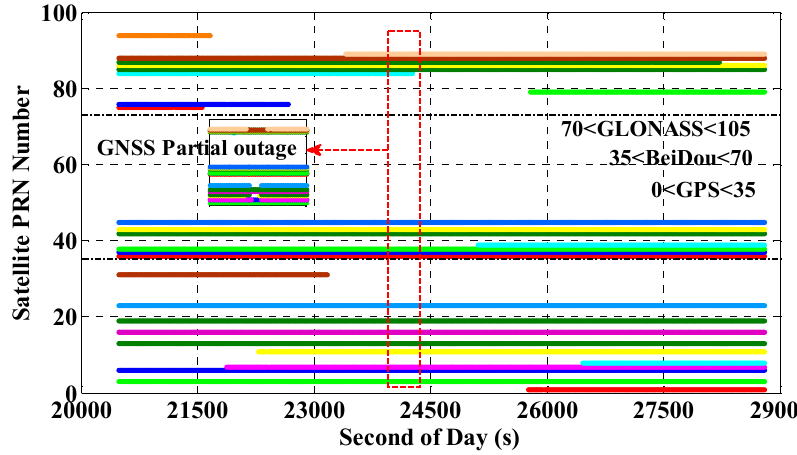
Figure 4. Availability of GPS (defining as PRN < 35), BeiDou (defining as 35 < PRN < 70), and GLONASS (defining as 70 < PRN < 105) of land vehicle experiment on 19 June 2013 in Wuhan, China; the red dashed box shows a GNSS partial outage caused by users’ observing environment.